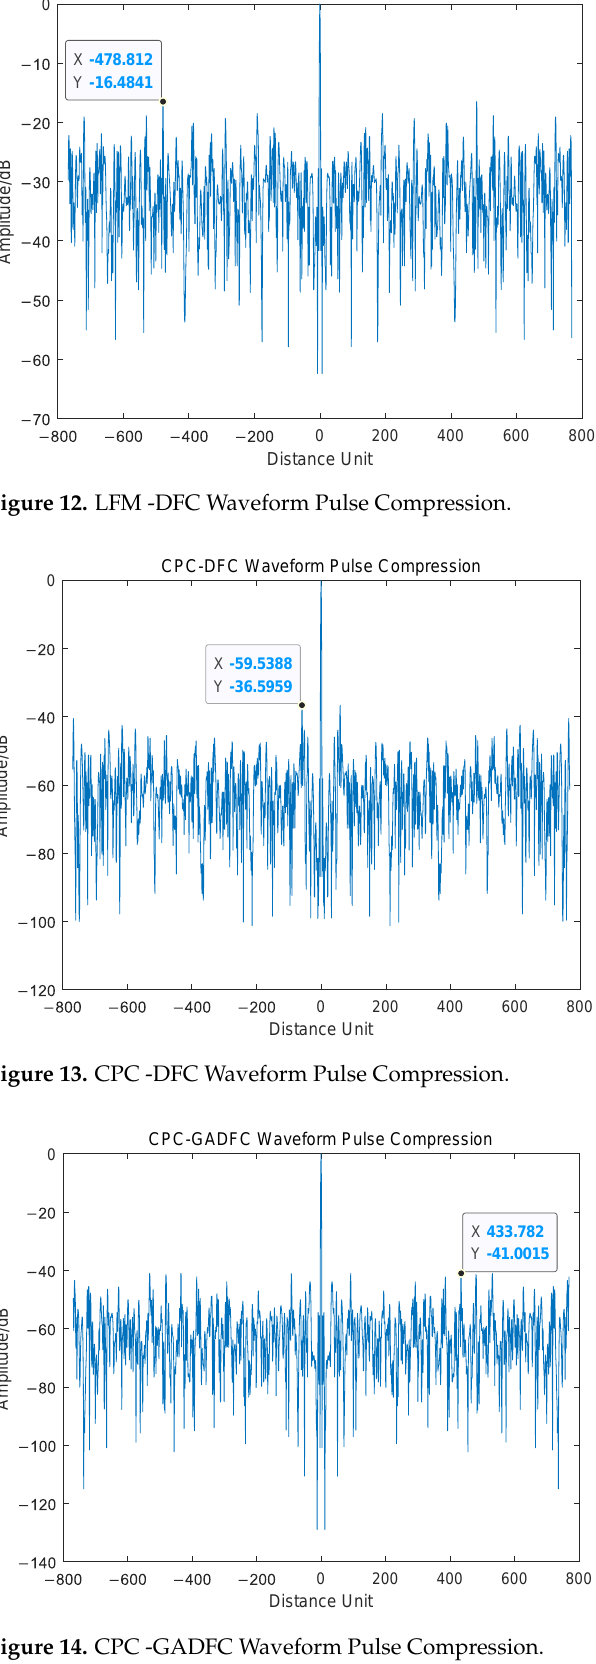
Figure 14. CPC -GADFC Waveform Pulse